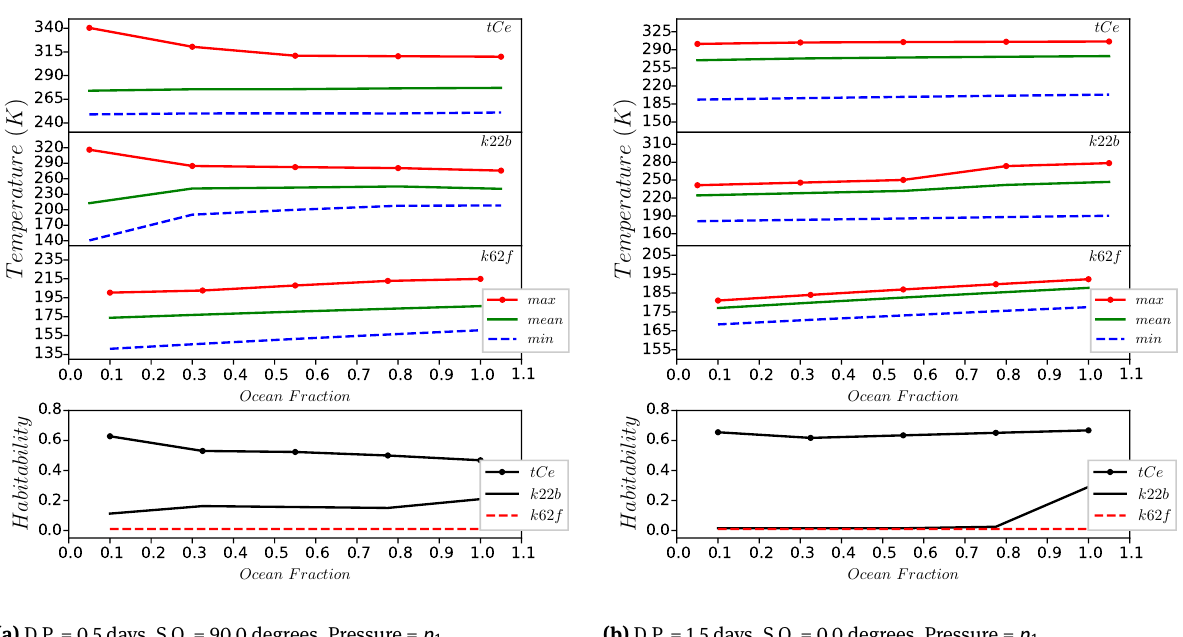
(a) D.P. = 0.5 days, S.O. = 90.0 degrees, Pressure = p 1 (b) D.P. = 1.5 days, S.O. = 0.0 degrees, Pressure = p 1